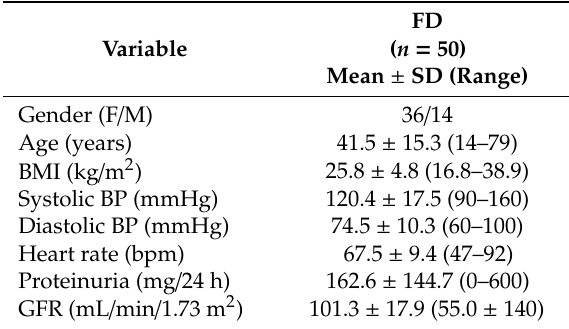
Table 1. Clinical features of the study population.